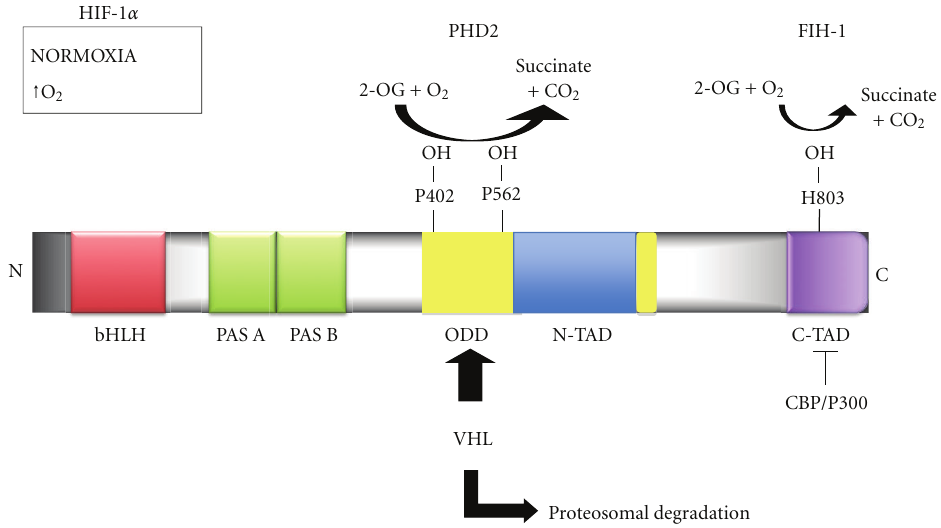
Figure 1: Structure of HIF-1 α and the oxygen-dependent regulation of HIF-1 α protein stabilisation and activation: The N-terminal regions contain the basic helix-loop-helix (bHLH) domain involved in DNA-binding and the Per-Arnt-Sim (PAS) A and B domains required for heterodimerisation with HIF-1 β . The oxygen-dependent degradation domain(ODD) is where PHD2 hydroxylates proline residues P402 and P562, which enables binding of VHL and proteosomal degradation. The terminal transcriptional activation domains (TADs) are responsible for transactivation of target genes. The N-TAD is located towards the N-terminus, with the C-TAD located at the extreme C-terminus. Factor inhibiting HIF-1 (FIH-1) hydroxylates asparagine H803 in the C-TAD, preventing the binding of coactivators CBP/p300, thus inhibiting activation of HIF-1 α . Both hydroxylation processes use 2-oxoglutarate (2-OG) and O 2 as substrates and produce succinate and carbon dioxide (CO 2 ) as